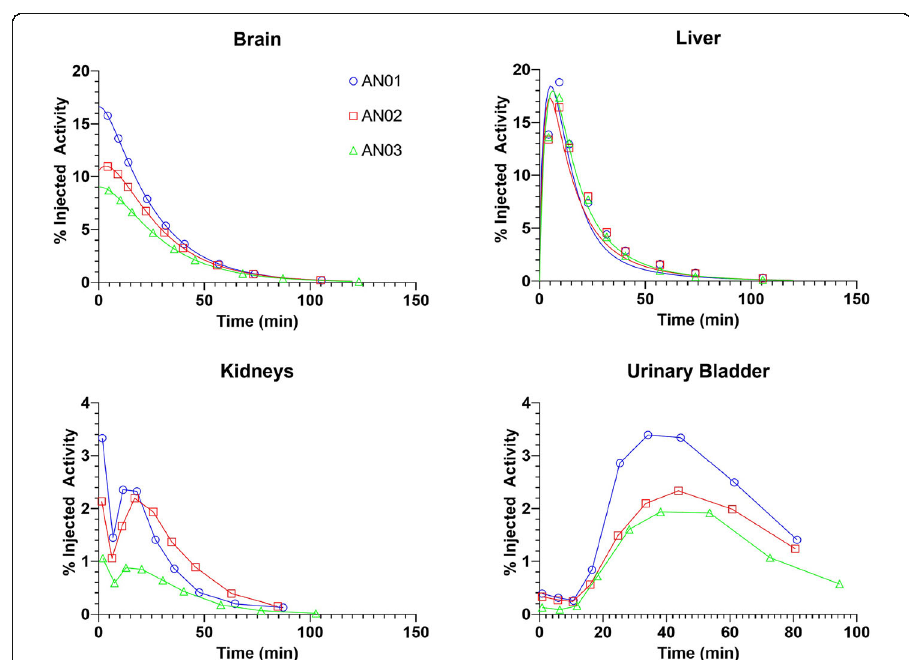
Fig. 2 Time-activity curves of select source organs (brain [ a ], liver [ b ], kidneys [ c ], and urinary bladder [ d ]) after [ 11 C]-UCB-J injection in 3 subjects. Graphs indicate non-decay corrected mean organ radioactivity